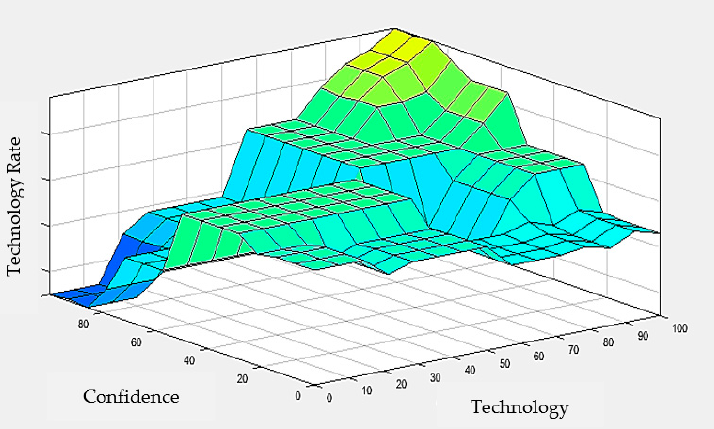
Figure 16. The graph of the correlations between current technology, confidence, and technology rate for the proposed method. Table 6. Summary of the variables for the regression equation for confidence rates.